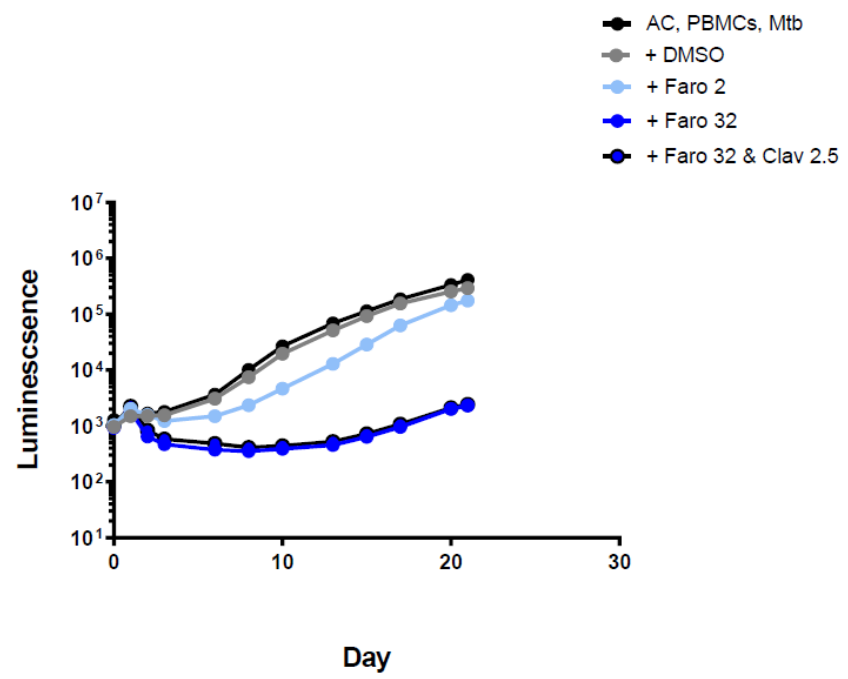
Figure 4. Luminescence detection at different time points for faropenem in TB-infected PMBCs obtained from donor 1. AC: alginate collagen; PMBCs: peripheral blood mononuclear cells; Mtb: Mycobacterium tuberculosis; DMSO: dimethyl sulfoxide; Faro 2: Faropenem 2 mg/L; Faro 32: Faropenem 32 mg/L; Clav 2.5: clavulanic acid 2.5 mg/L. Standard deviation included but are very small, i.e., within the size of the points on the curve.